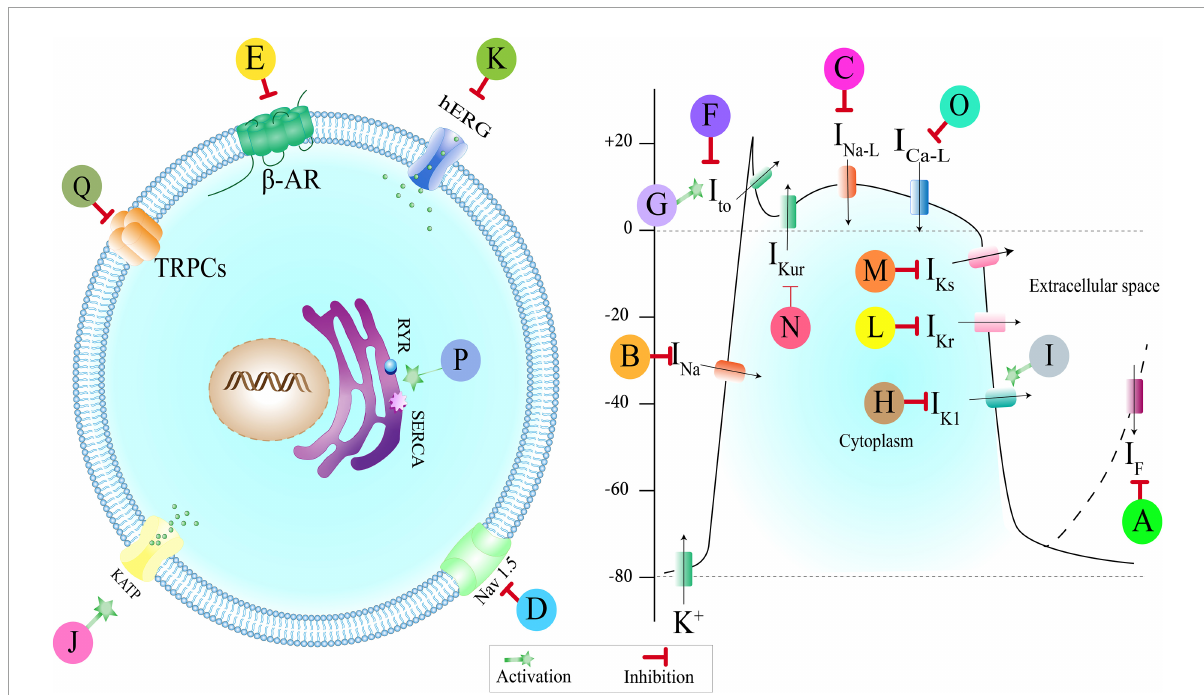
FIGURE3 Medicinal plants, multi-component herbal preparations, and phytochemicals with an antiarrhythmic effect based on their effect on ionic channels. Some of them have more than one mechanism. Class (0): A: Shensong Yangxin capsule, Ginkgo biloba. Class (I): B: Andrographolide, Oxymatrine, Liriodenine, Arctigenin, Resveratrol, C: Wenxin Keli, Curcumin, Barbaloin, D: Dingji Fumai decoction, Xin Su Ning. Class (II): E: olea europaea. Class (III): F: Wenxin Keli, Shensong Yangxin capsule, Allicin, Resveratrol, Cinnamophilin, Acacetin, G: Oxymatrine, H: Berberin, Shensong Yangxin capsule, Oxymatrine, I: Tanshinone IIa, Rhodiola spp., J: Sasanquasaponin, Total flavonoids from Hypericum attenuatum, K: Xin Su Ning, L: curcumin, M: Resveratrol, N: Acacetin. Class (IV): O: Wenxin Keli, Allicin, Total flavonoids from Hypericum attenuatum , flavonoid extract of Viscum coloratum, Ginsenoside Rb1, Oxymatrine, Curcumin, Arctigenin, Cinnamophilin, Barbaloin, Resveratrol, Rhodiola spp., P: Rhodiola spp. Class (V): Q: Salvianolic acid-B. I F : Pacemaker current, I Na : Sodium currents, I Na − L : Late sodium currents, Nav: voltage-gated sodium channel, I to : Transient outward current, I K1 : Inward rectifier current, K ATP : ATP activated K + channels, hERG: Human Ether-a-go-go-related Gene (hERG) Potassium Channel, I Kr : Rapid delayed rectifier current, I Ks : Slow delayed rectifier current, I Kur : Ultrarapid delayed rectifier currents, I Ca − L : L-type-calcium current, RYR: Ryanodine receptors, SERCA: Sarcoendoplasmic reticulum calcium transport ATPase, TRPCs: Transient receptor potential canonical channels, β -AR: Beta-adrenergic